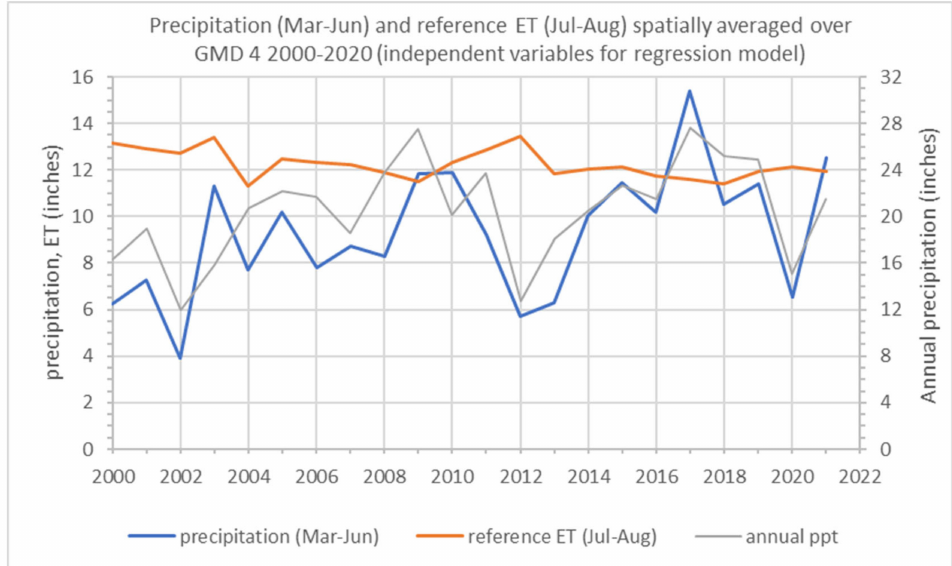
Figure A1. Predictive climatological variables used to estimate pumping for GMD 4 2000–2020 are reference ET (Jul–Aug, blue) and precipitation (Mar–June, orange), both plotted against the left axis. Annual precipitation, plotted against the righthand axis, is shown for comparison.